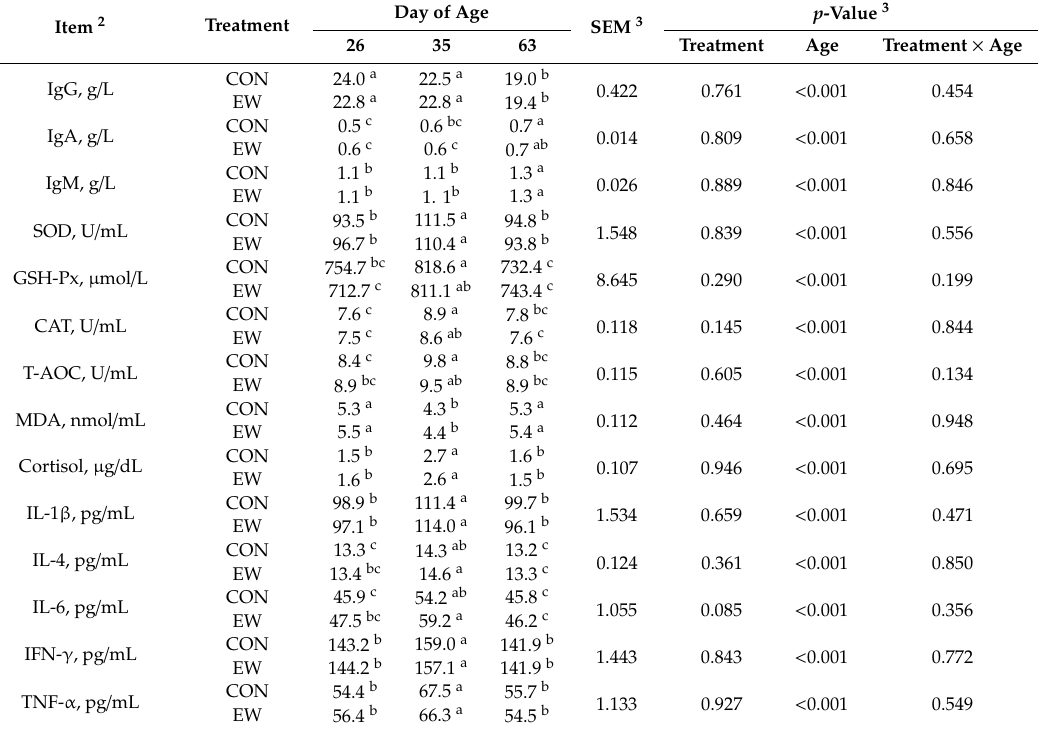
Table 4. Serum parameters of lambs at 26, 35, and 63 days of age